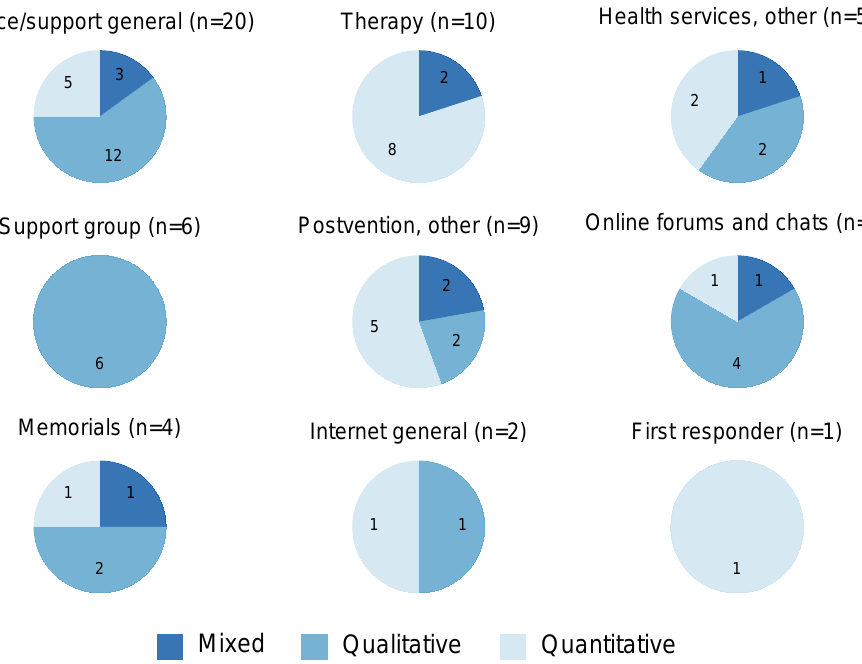
Figure 3. Service and support type. Number of studies. Distribution on study type. N = 63.